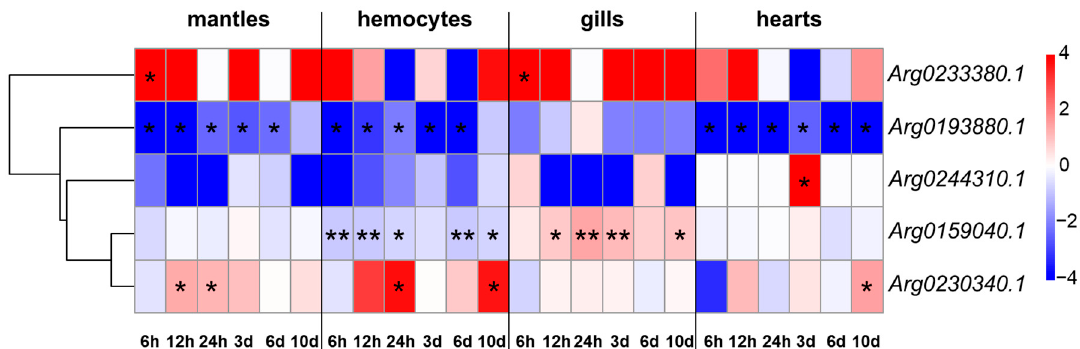
Figure 7. Heat map of AiPC4 expression patterns of bay scallop tissues (mantles, hemocytes, gills and hearts) in response to high-temperature stimulation (32 °C) along different time points based on log 2(TPM values) . Differently colored boxes highlight different expression patterns. Significant ( p < 0.05) and extremely significant ( p < 0.01) difference are indicated through “*” and “**”,